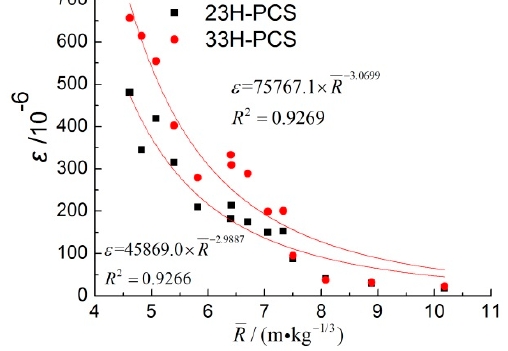
Figure 6. PCS of 23H and 33H ( R = 2.7 m and R = 3.75 m).